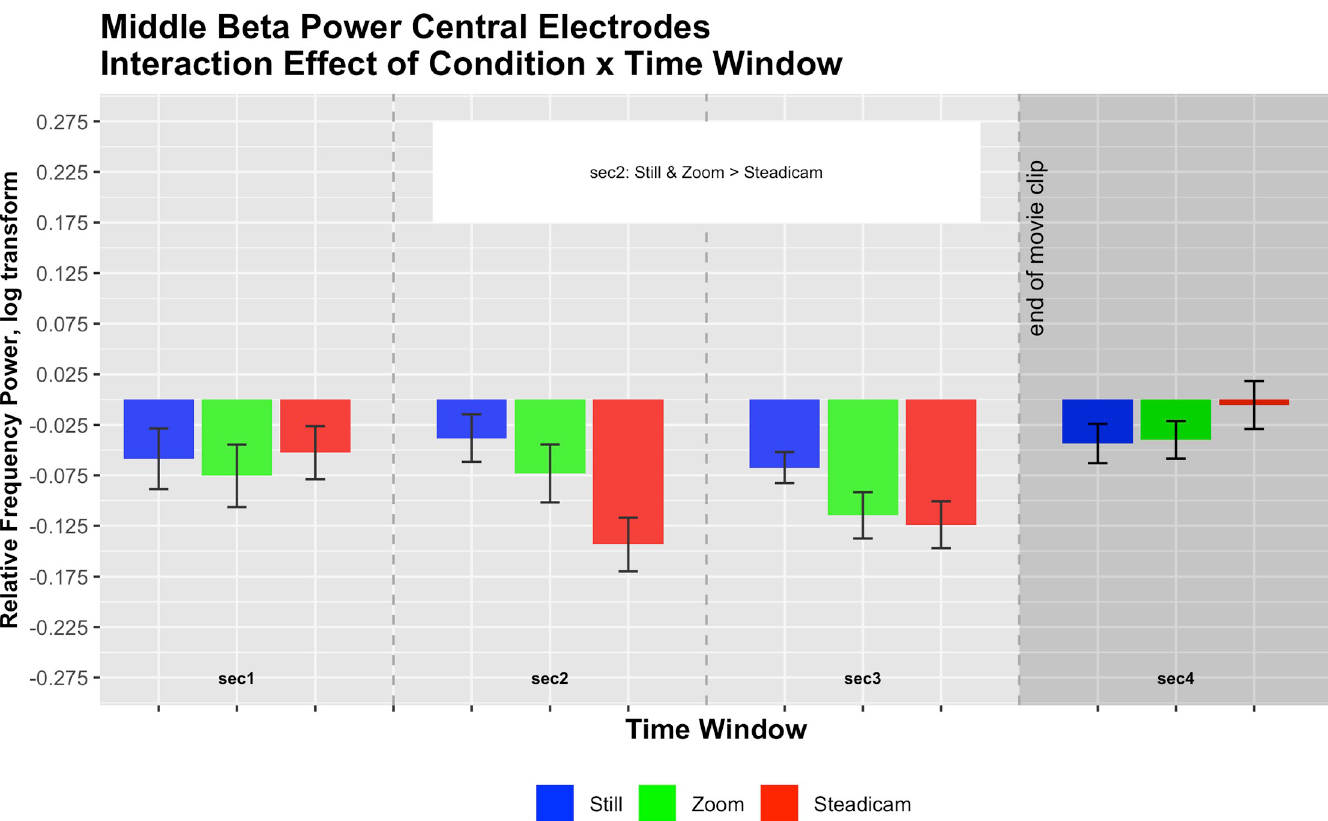
Fig 6. Central middle beta frequency power (log corrected for normality) in the three observation conditions across the four time windows. F(6,90) = 5.96, p < 0.001, partial eta squared =